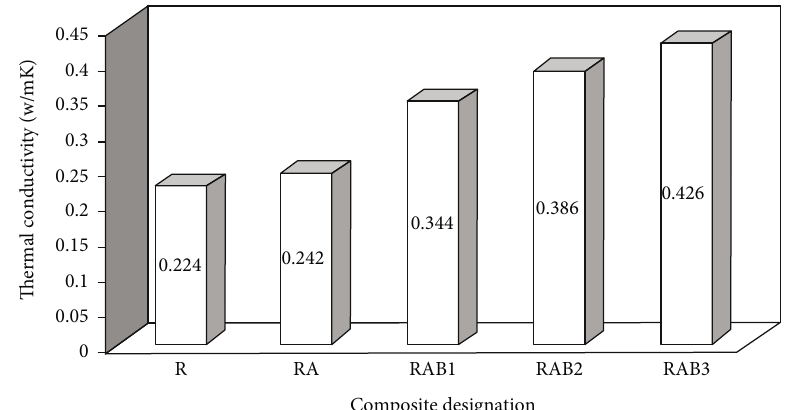
Figure 8: Thermal conductivity of composites.